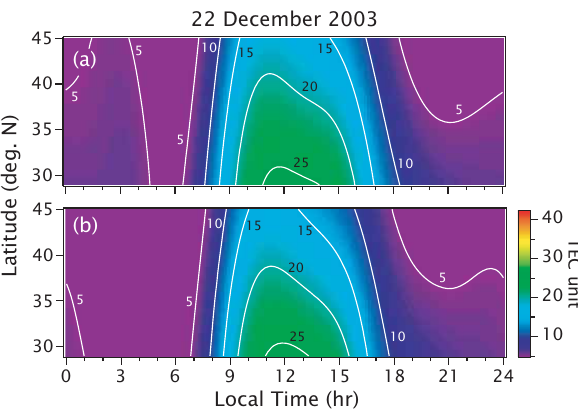
Fig. 8. Same as Fig. 5 but for December solstice 2003.